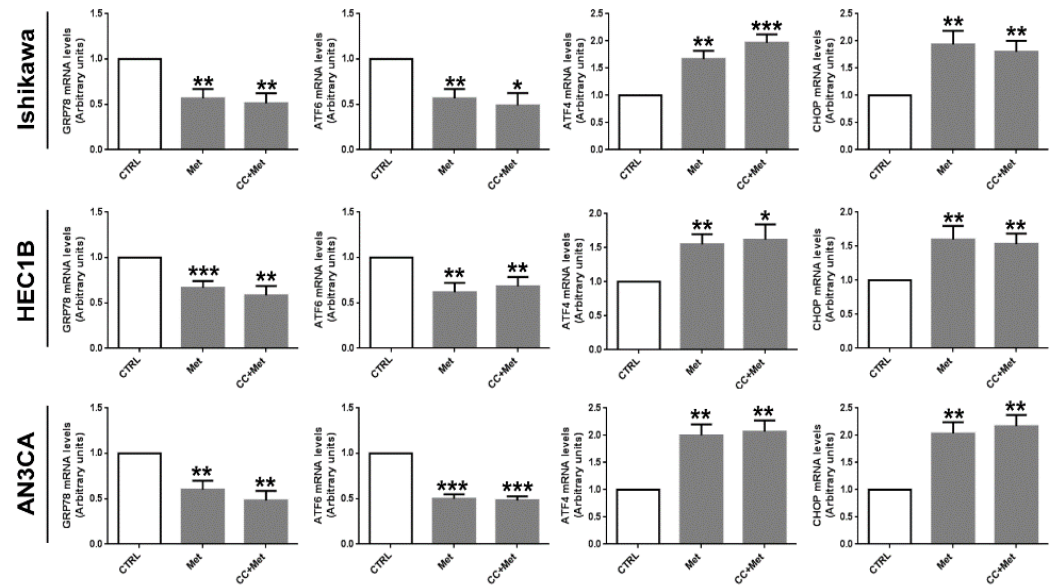
Figure 3. Metformin modulates the mRNA expression of UPR genes in an AMPK-independent manner in endometrial cancer cells. Ishikawa, HEC1B, or AN3CA cells were treated or not for 24 h with 5 mM metformin in the presence or absence of 1 h pretreatment with 10 µ M CC. Total RNA was extracted and real-time RT-PCR experiments were performed using oligonucleotides specific for GRP78, ATF6, ATF4, CHOP, and GAPDH as described in the Section 2.4. Values shown represent the mean ( ± s.d.) of triplicate samples of three independent experiments. * p < 0.1; ** p < 0.05; *** p < 0.01.